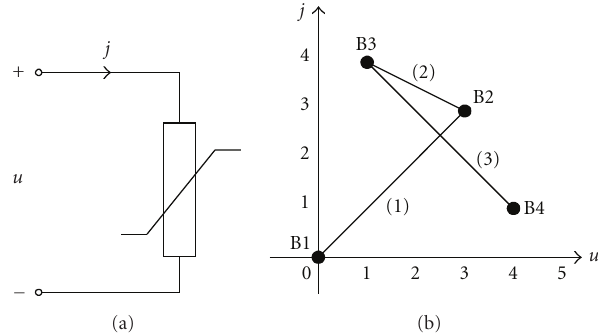
Figure 5: (a) Nonlinear element, (b) PWL characteristic for the nonlinear element.